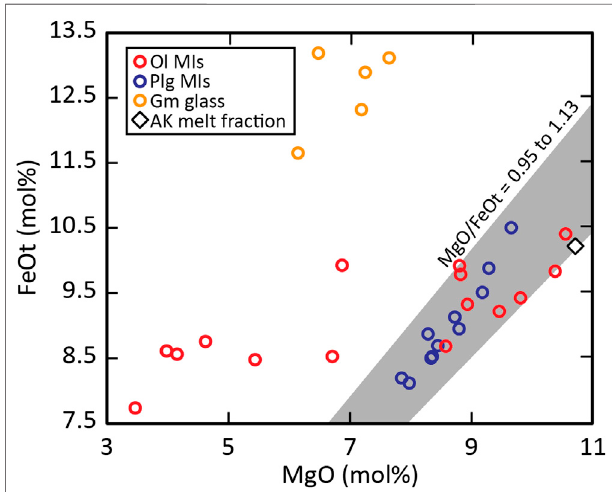
FIGURE 6 | MgO vs FeOt variation diagram of all glass analyses of the AK sample. The red circles are the uncorrected olivine-hosted MIs, the blue circles are the plagioclase-hosted MIs, the yellow circles are the groundmass glass analyses and the less PEC affected olivine-hosted MIs, the plagioclase-hosted MIs and the estimated AK melt fraction composition follows a path of narrow MgO/FeOt ratios between 0.95 and 1.13, marked by the grey